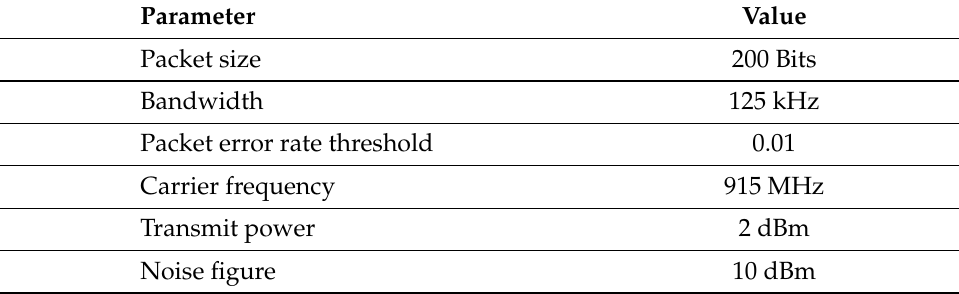
Table 1. Simulation Parameters.